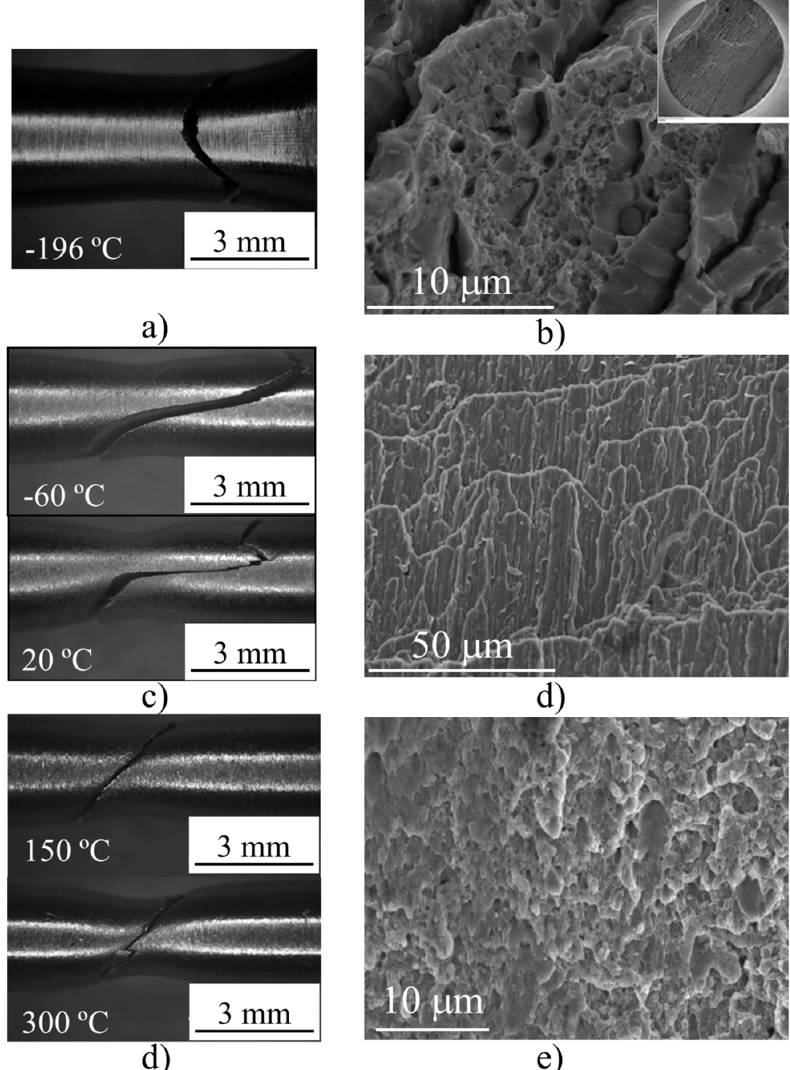
Figure 5. ( a ) Optical macrographs showing the breaking mode of tensile specimens of the PM2000 alloy tested at different temperatures; ( b ) SEM images showing the delaminations in the inset and the fractographic features of the fracture surface of tensile specimens tested at − 196 °C; ( c ) SEM image of representative features of the fracture surface of tensile specimens tested at − 60 °C and +20 °C; ( d ) SEM image of representative features of the fracture surface of tensile specimens tested at +150 °C and 300 °C.